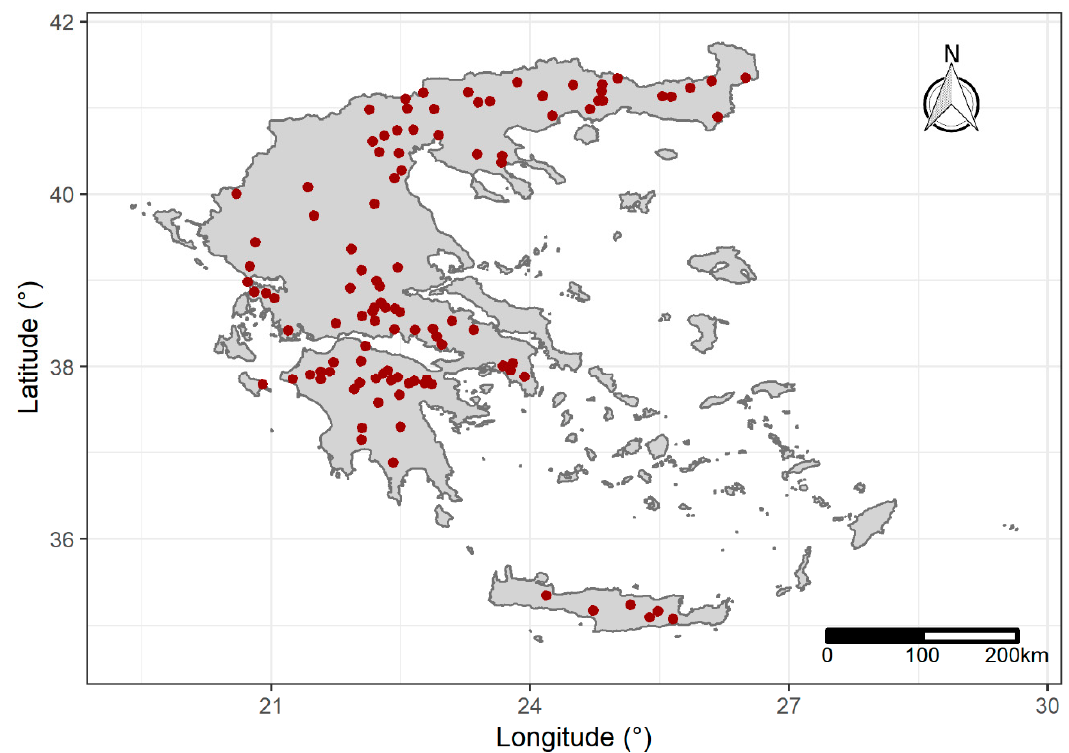
Figure 2. Station locations in Greece used in the analysis obtained from the Greek National Bank of Hydrological and Meteorological Information.